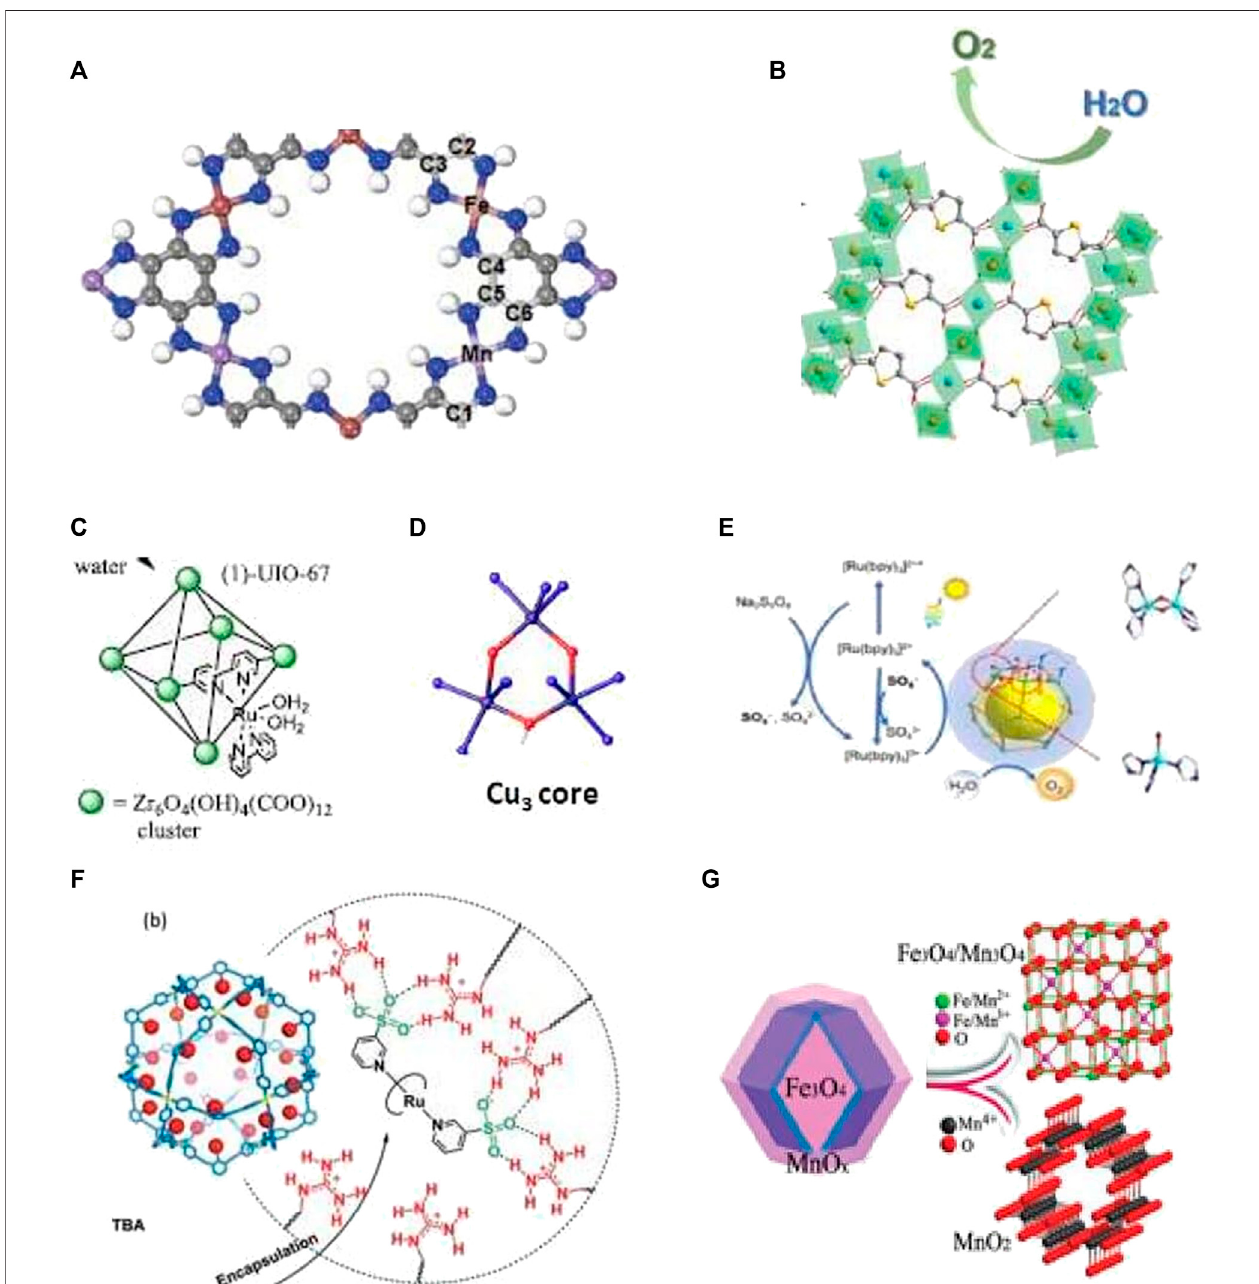
FIGURE2| MCforWSandOreduction. (A) Mn/Fe-hexaiminobenzeneMOFforelectrocatalyticoxygenreductionreaction andOER(Shindeetal,2019). (B) Fe – Ni MOF electrocatalyst for water oxidation (Wang K. et al, 2021). (C) Active water oxidation catalyst cis-[Ru(bpy) (5,5 ′ dcbpy) (H ₂ O) 2 ] 2+ (1) incorporated into UIO-67 MOF (Ezhov et al, 2020) (D) Cu-core of the bioinspired catalyst for water oxidation (Chen Z. -Y. et al, 2021). (E) Co-based MOC for photo-driven water oxidation (Chen Q. F. et al. 2021). (F) Preorganization of the ruthenium catalyst in self-assembled nanospheres for electrochemical water oxidation (Yu et al, 2018). (G) Hierarchical Fe – Mn binary metal oxide core-shell nano-polyhedron for electrochemical WS (Li et al, 2021).